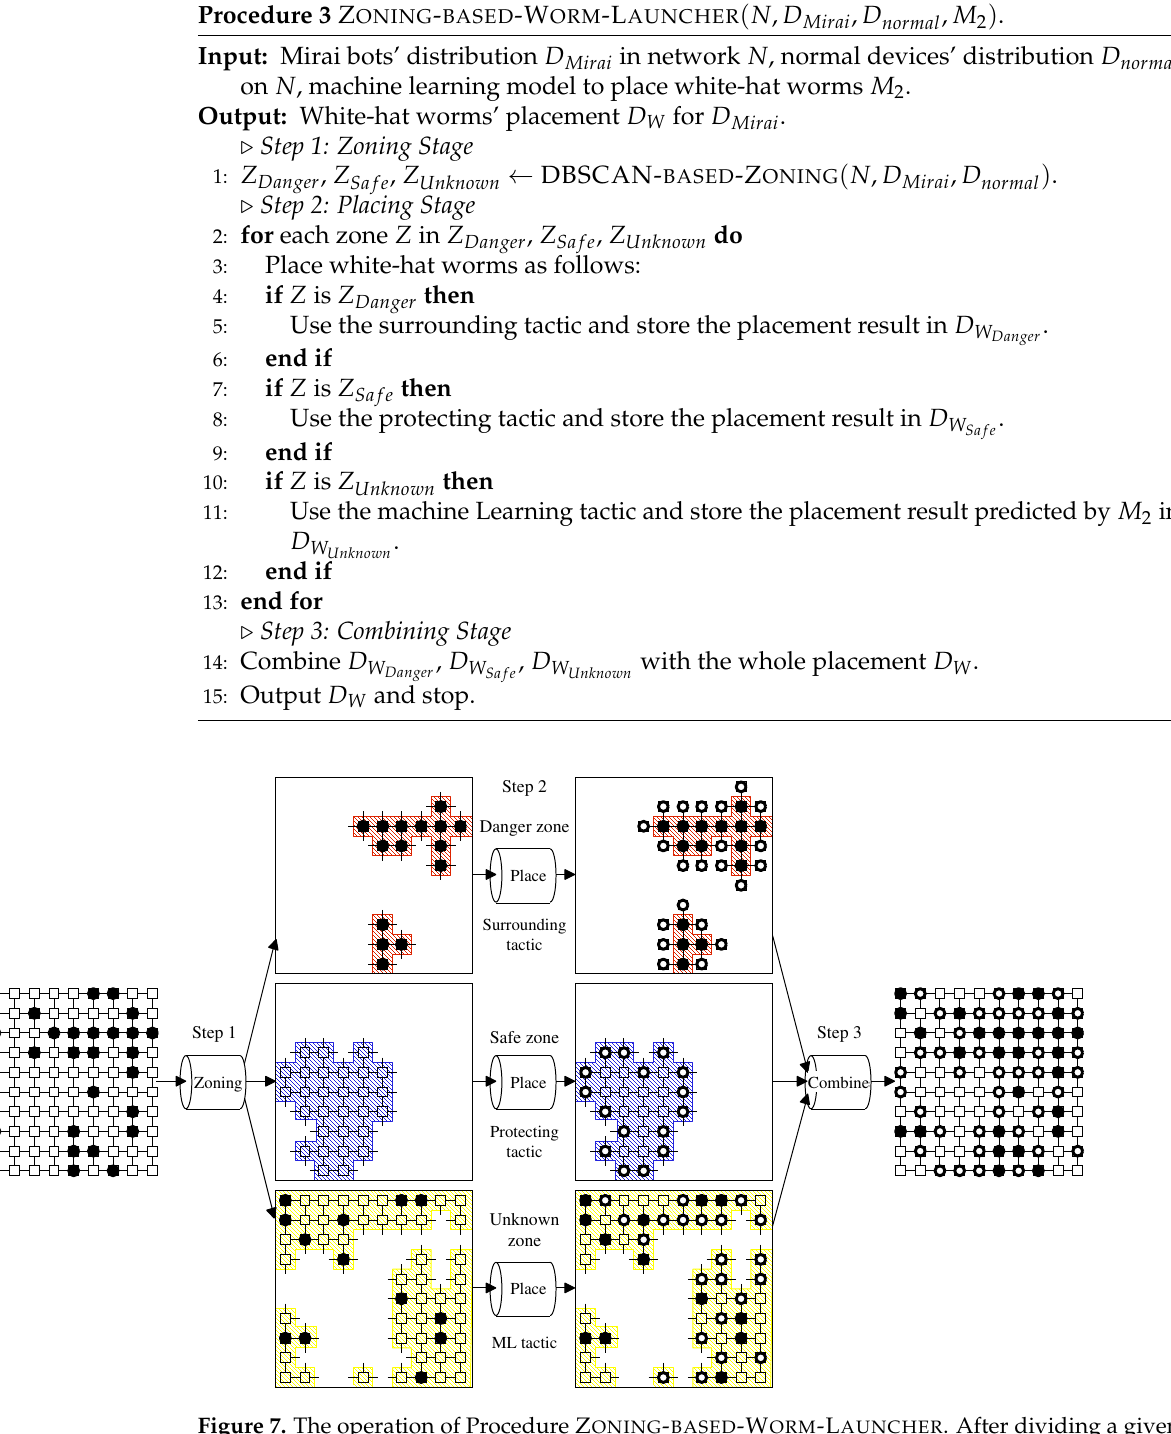
Figure 7. The operation of Procedure Z ONING - BASED -W ORM -L AUNCHER . After dividing a given 10 × 10 network into three zones based on the Mirai bots’ density, the Launcher places white-hat worms according to the tactic for each